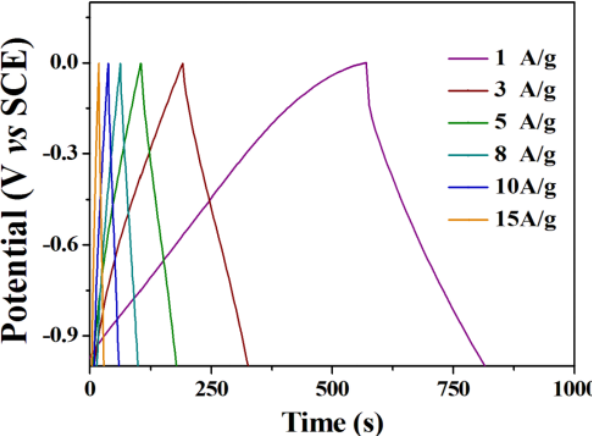
Figure 4. Charge – discharge curves of the CNTs electrode at different current densities. Figure 4. Charge–discharge curves of the CNTs electrode at different current densities.